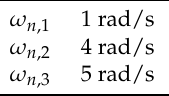
Table 1. Estimated natural frequencies for the three actuators.